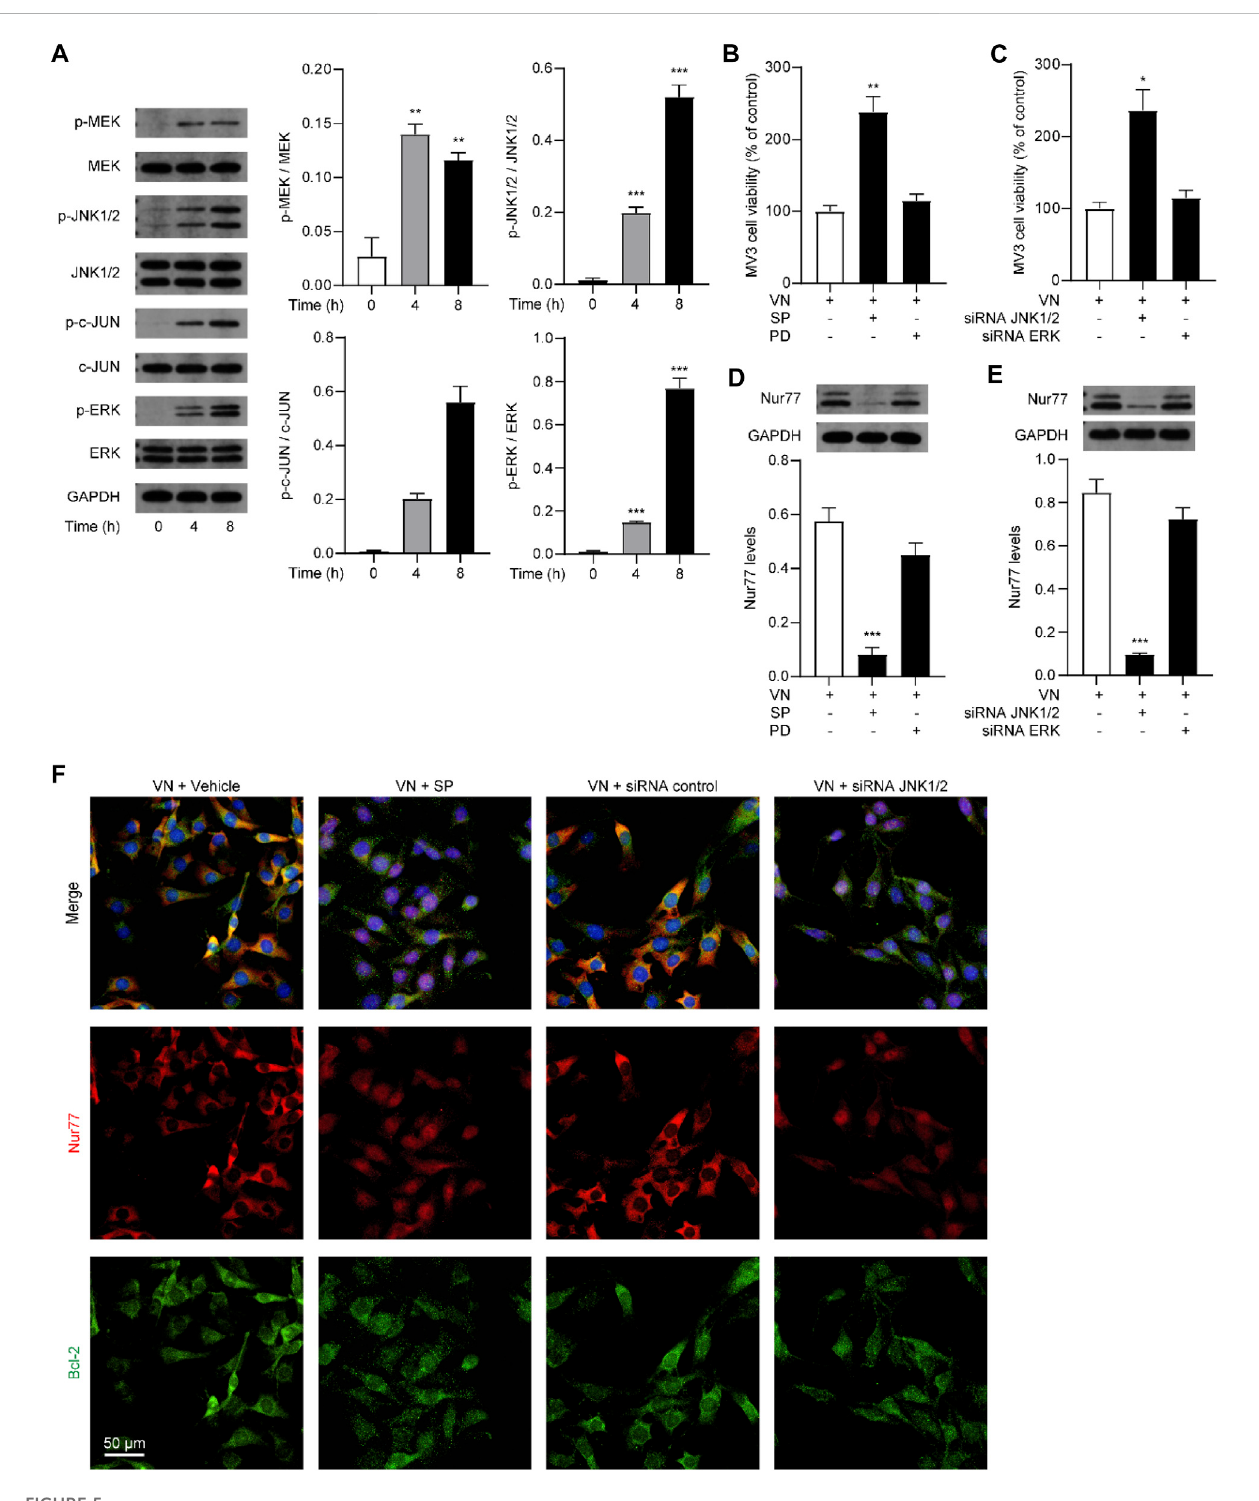
FIGURE 5 Activation of ERK1/2 signaling was necessary for venlafaxine-induced apoptosis. (A) Representative western-blot bands and quanti fi cation of the MAPK signal molecules abundances in MV3 cells treated with venlafaxine (10 μ M) for 0 – 8 h (B) MV3 cells were treated with vehicle, JNK1/2 inhibitor SP600125 and MERK/ERKinhibitorPD98059for72 h.CellviabilityweremeasuredbyCCK-8kitsat72 h (C) MV3cellsweretransfectedwithsiRNAcontrol,JNK1/2siRNA,and ERK siRNA for 72 h. Cell viability were measured by CCK-8 kits at 72 h (D,E) Representative western-blot bands and quanti fi cation of Nur77 abundances in MV3 cells treated with venlafaxine (10 μ M) for 8 h, or transfected with siRNA control, JNK1/2 siRNA, and ERK siRNA for 20 h (F) MV3 cells were immunostained with Bcl-2 and Nur77 antibodies and visualized by confocal microscopy. N = 3, *, p < .05, **, < .01, ***, p < .001 vs.